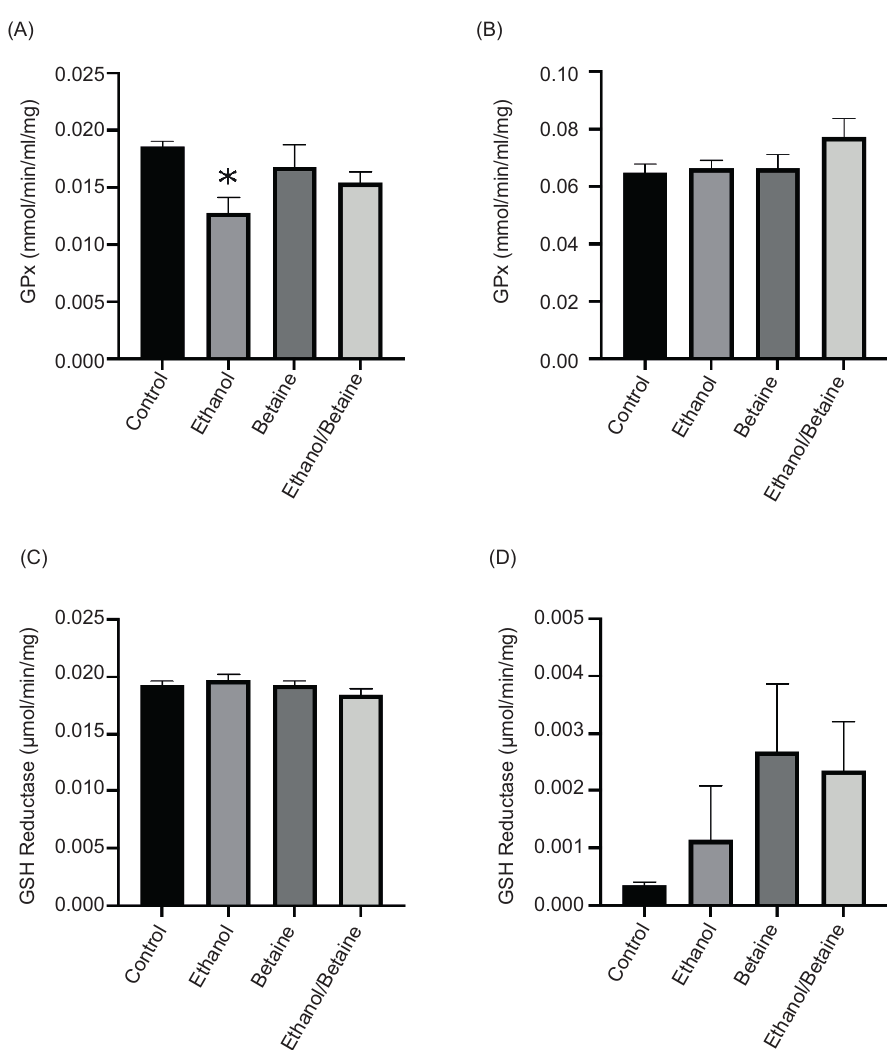
Figure 3: The effect of betaine on ethanol-induced changes in (A) cytosolic GPx activity, (B) mitochondrial GPx activity, (C) cytosolic GSH reductase activity, and (D) mitochondrial GSH reductase activity. Following treatment, liver mitochondrial and cytosolic fractions were prepared as previously described, and the antioxidant enzyme activity was determined as described in the methods. Values are expressed as mean ± SEM (n = 3–4). *P < 0.05 compared to control.